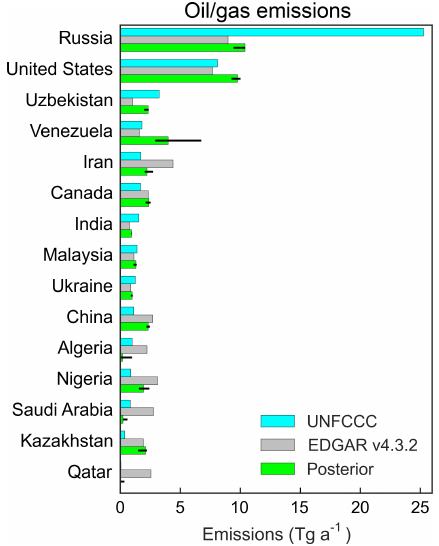
Figure 6. National estimates of methane emissions from the oil and gas industry for countries in the top 10 of either the EDGAR v4.3.2 or UNFCCC inventories. Values reported by individual countries to the UNFCCC for 2012 (Annex I countries) or the closest year (non-Annex I countries: Nigeria (1994), Venezuela (1999), Algeria (2000), Iran (2000), India (2010), Saudi Arabia (2010), and China (2012)) are compared to 2012 emissions from EDGAR v4.3.2 na- tional oil and gas totals and to the posterior values from our base inversion as described in the text. Black lines are ranges for the en- semble of inversions. A large part of Russian emissions are too far north to be effectively constrained by the